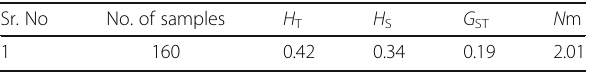
Table 4 Diversity indices of 160 S. asoca accessions Sr.